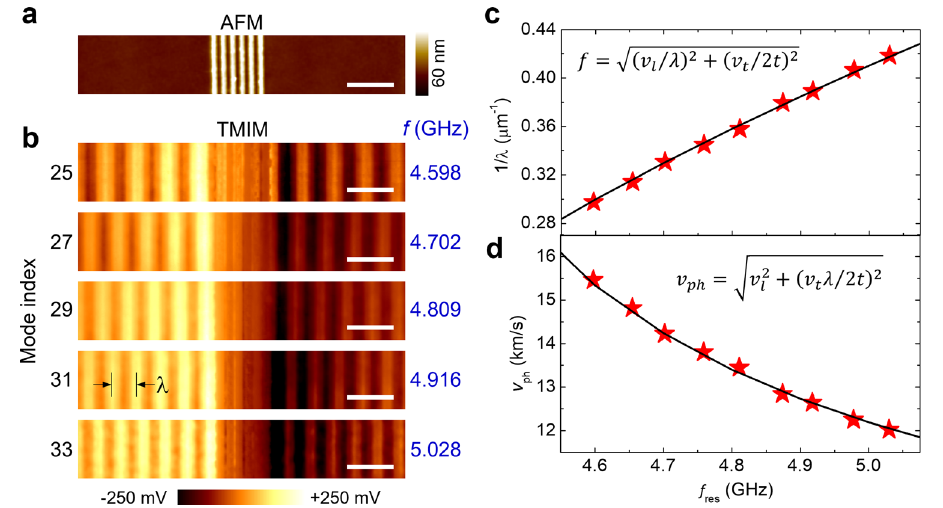
5 μ m. c Measured1/ λ and d phasevelocityasafunctionoftheresonantfrequency. The lines fi t the equations based on quasi-static approximations.